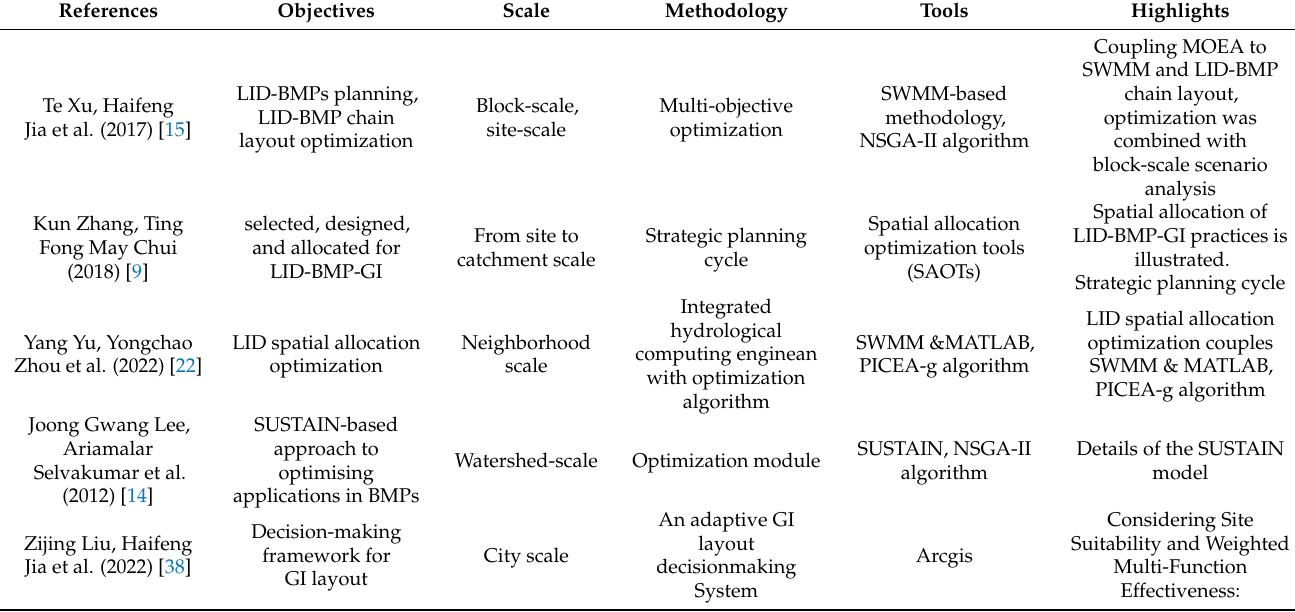
Table 11. Comparison of this study with related